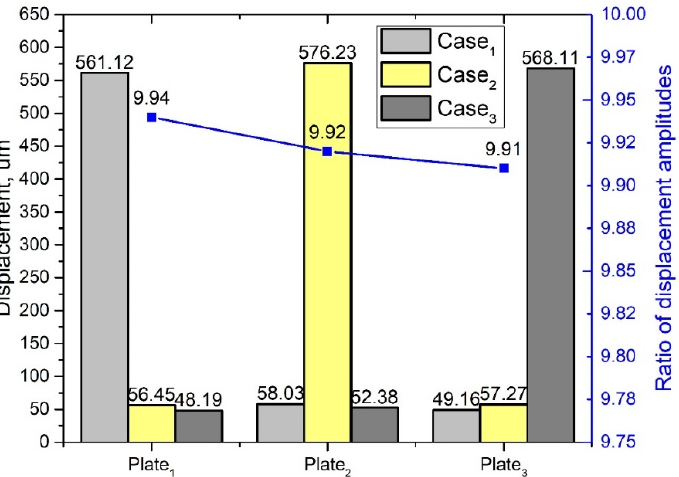
Figure 9. Summary of displacement amplitudes while different excitation cases are used. The dependence of displacement and velocity amplitudes of the contact point (CP) from excitation voltage were investigated in the frequency domain. The study conducted only when Plate 1 was excited (Table 2, Case 1 , forward). The analyzed voltage range was set as follows: the lower limit of excitation voltage was set to 30 V p-p , the upper limit of excitation voltage was set to 210 V p-p while an increment of 20 V p-p was used. The displacement amplitude-frequency characteristic shows peaks of displacement amplitude that were obtained at the frequency of 23.673 kHz (Figure 10). The displacement amplitude reached 561.12 µm and the ratio between contact point (CP) displacement amplitude and the applied voltage is 2.67 µm/V p-p . On the other hand, minimum displacement amplitude was obtained at the same frequency while excitation voltage was 30 V p-p . The displacement amplitude reached 81.25 µm and the ratio of 2.71 µm/V p-p . It can be seen that almost linear dependence between displacement amplitude and excitation voltages was indicated. Therefore, control of the platform motion can be implemented using a simple electronic control system.